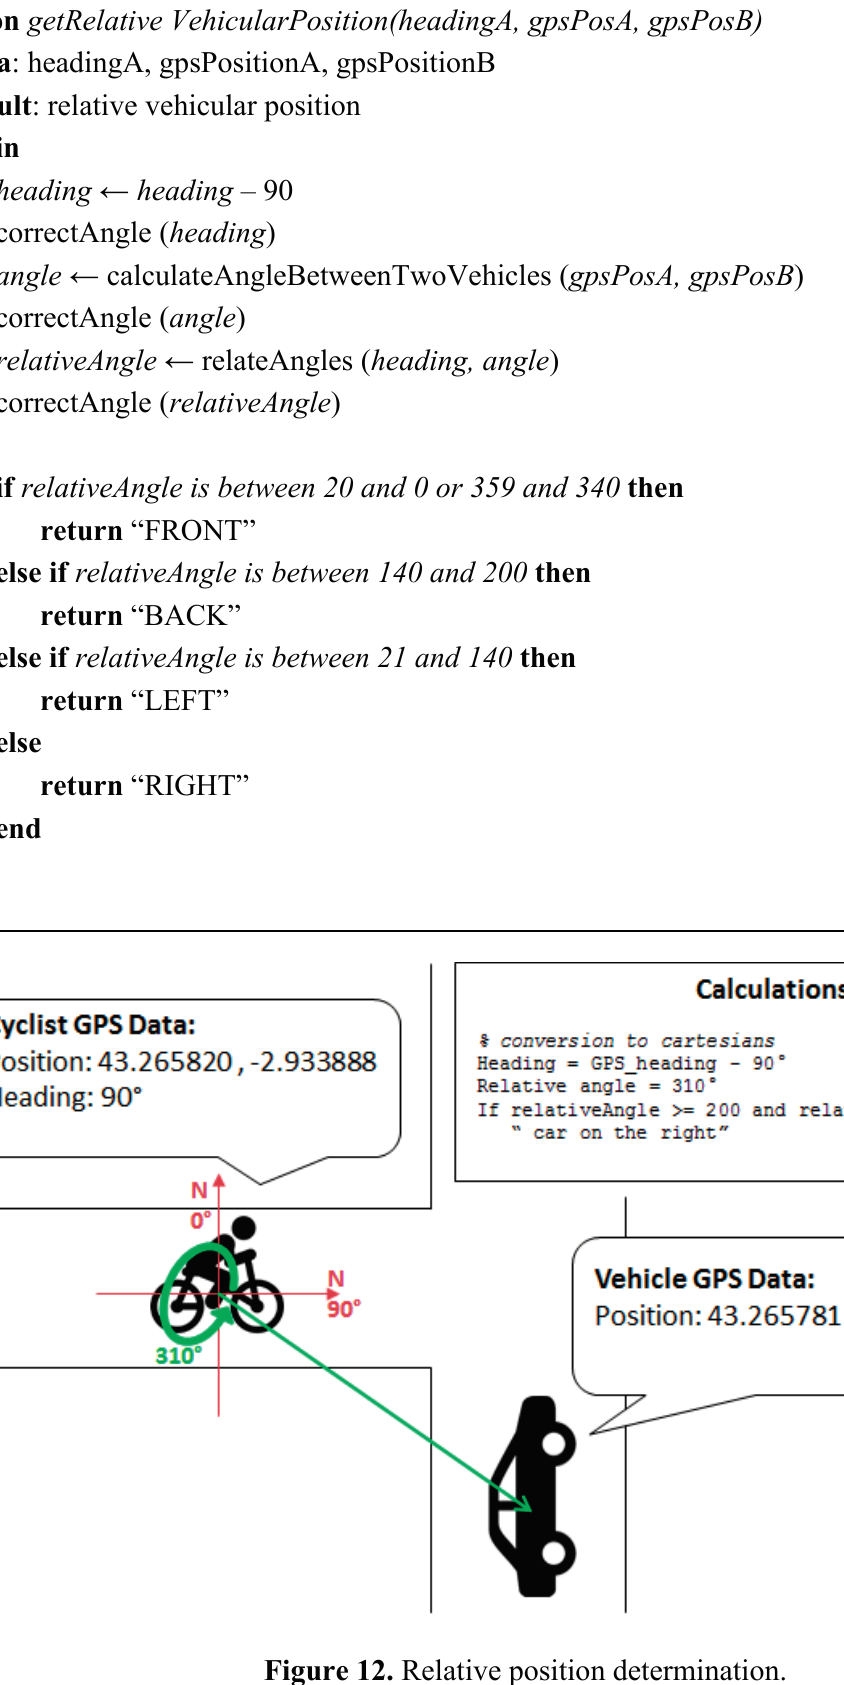
Algorithm 1 Relative position algorithm description